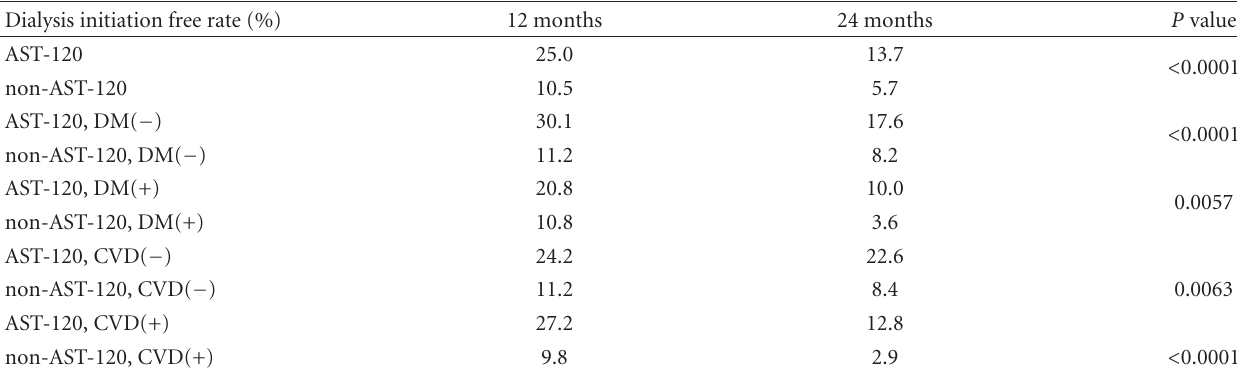
Table 4: The 12- and 24-month dialysis initiation free rate. The dialysis initiation free rate was significantly higher in the AST-120 group in all the pair-matched patients and also subgroups with or without DM or CVD.